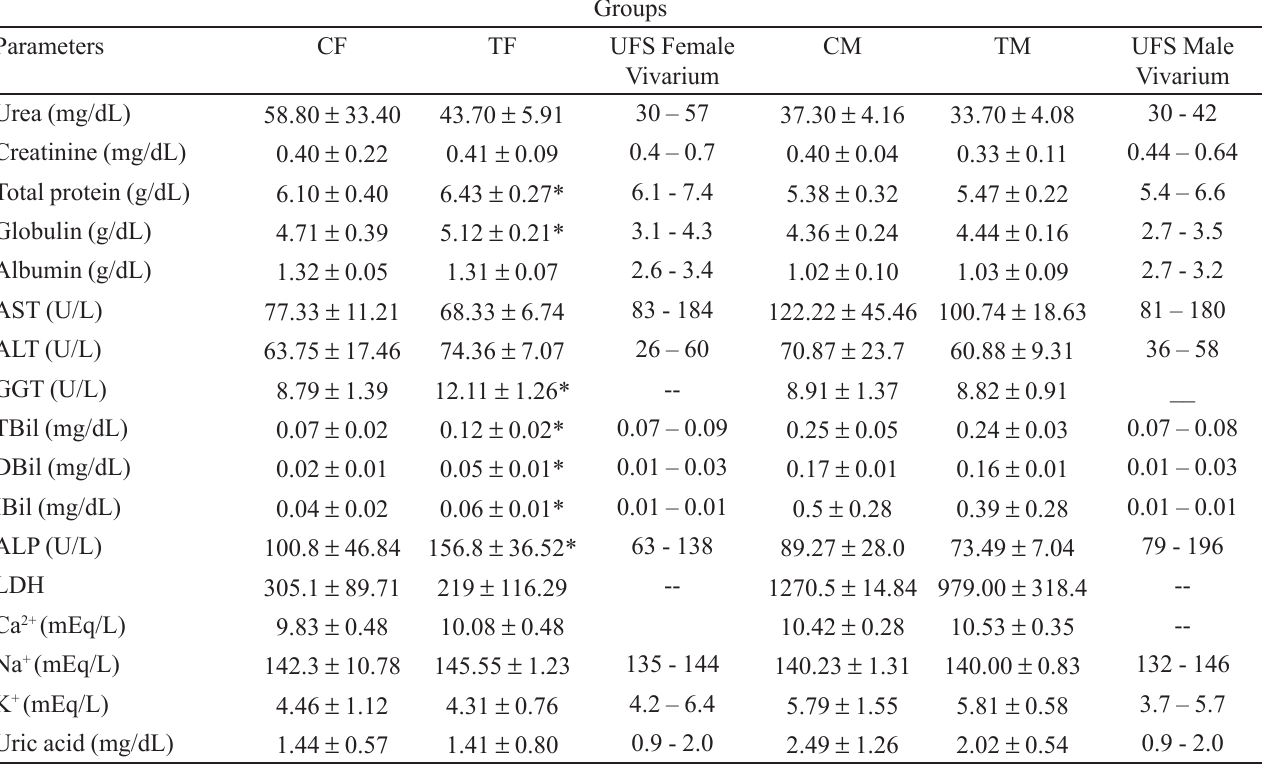
TABLE IV - Serum biochemical findings in rats treated with atranorin (ATR) at a daily dose of 50 mg/kg for 30